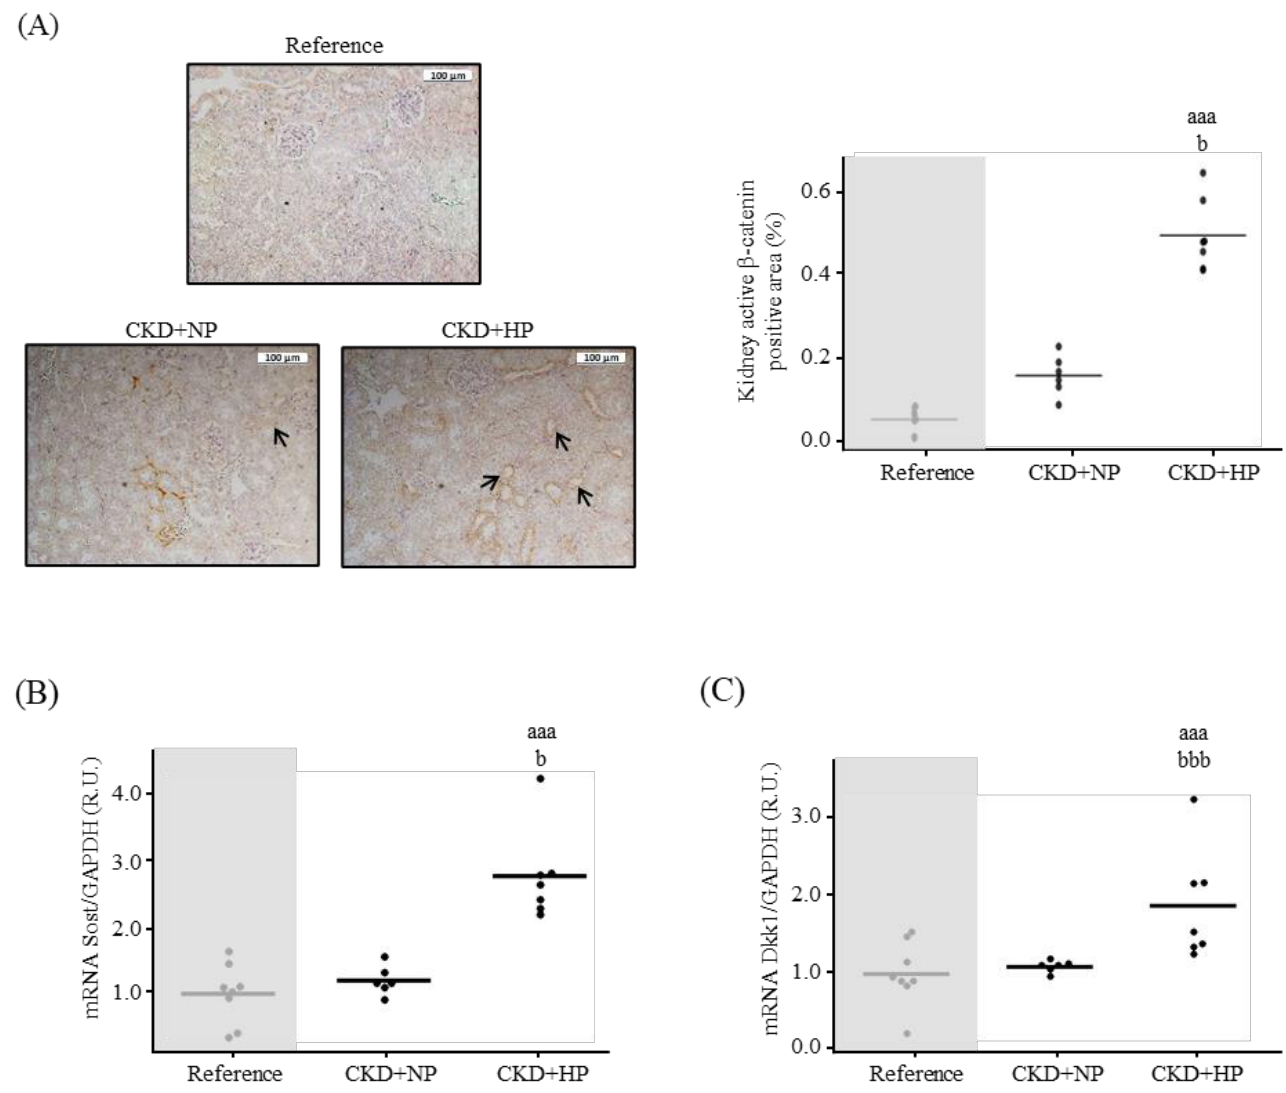
Figure 3. In vivo effects of chronic kidney disease (CKD) and dietary phosphorus intake on components of the Wnt/ β -catenin pathway in the kidney. ( A ) Representative images of kidney active β -catenin and its quantification from Sham (Reference) and CKD mice fed normal (NP) or high phosphorus (HP) diet for 14 weeks. Each inset indicates the relative scale in µ m. Kidney ( B ) Sost and ( C ) Dkk1 mRNA levels. All values are expressed relative to reference group. Mean and individual mice values are shown. aaa p < 0.005 vs. Reference, b p < 0.05 and bbb p < 0.005 vs. CKD+NP. R.U., relative units vs. Reference. GAPDH was used as housekeeping gene.